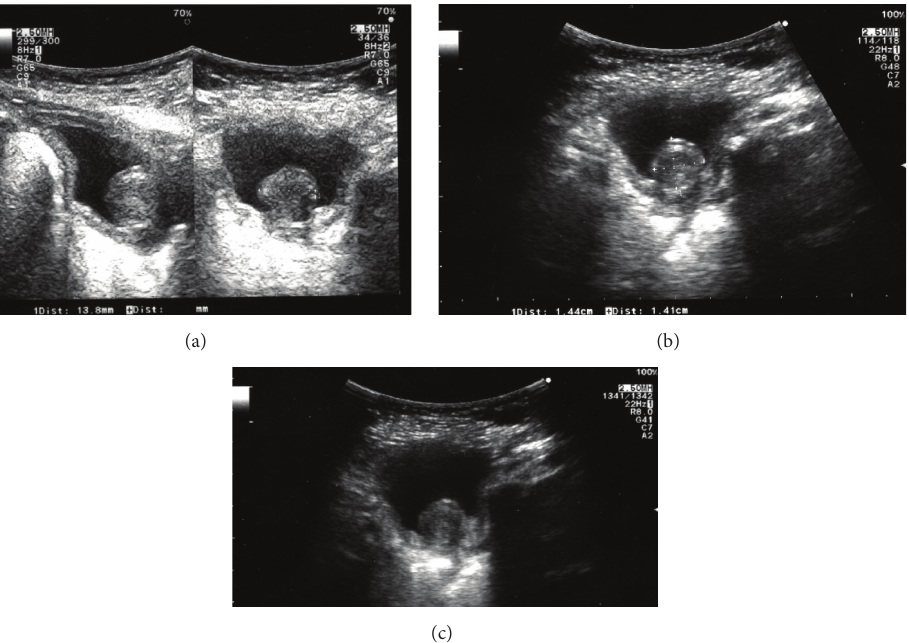
Figure 1: Ultrasound appearance of the mass: the solitary myofibroma arises from the bladder neck gaining the bladder lumen; (a–c): longitudinal and transverse US sections.